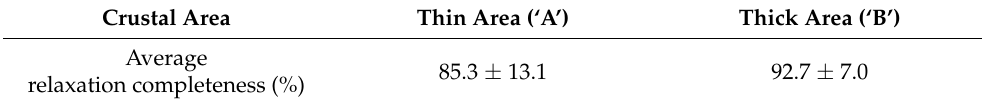
Table 3. Average post-seismic relaxation completeness in the two areas ‘A’ and ‘B’ in Figure 5. Crustal